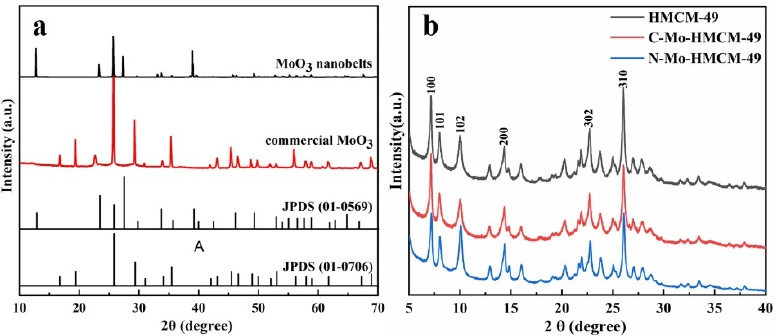
Figure 1. XRD patterns of ( a ) commercial MoO 3 and MoO 3 nanobelts, and ( b ) HMCM-49, C-Mo- HMCM-49, and N-Mo-HMCM-49. HMCM-49, and